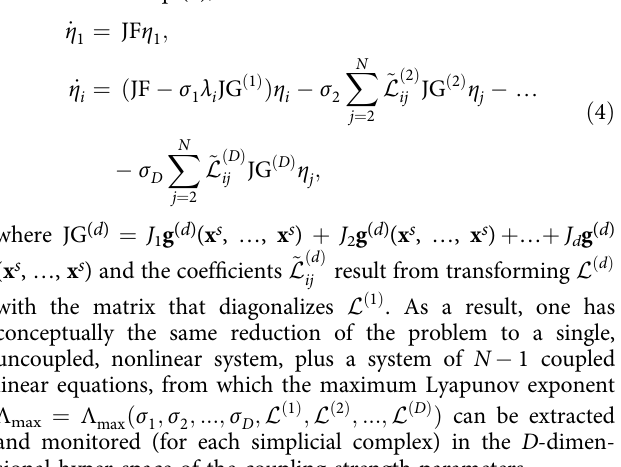
theoretical predictions of the synchronization thresholds obtained from Eq. (3). a , b , and c are examples of class III problems, whereas panels d and e are examples of class II